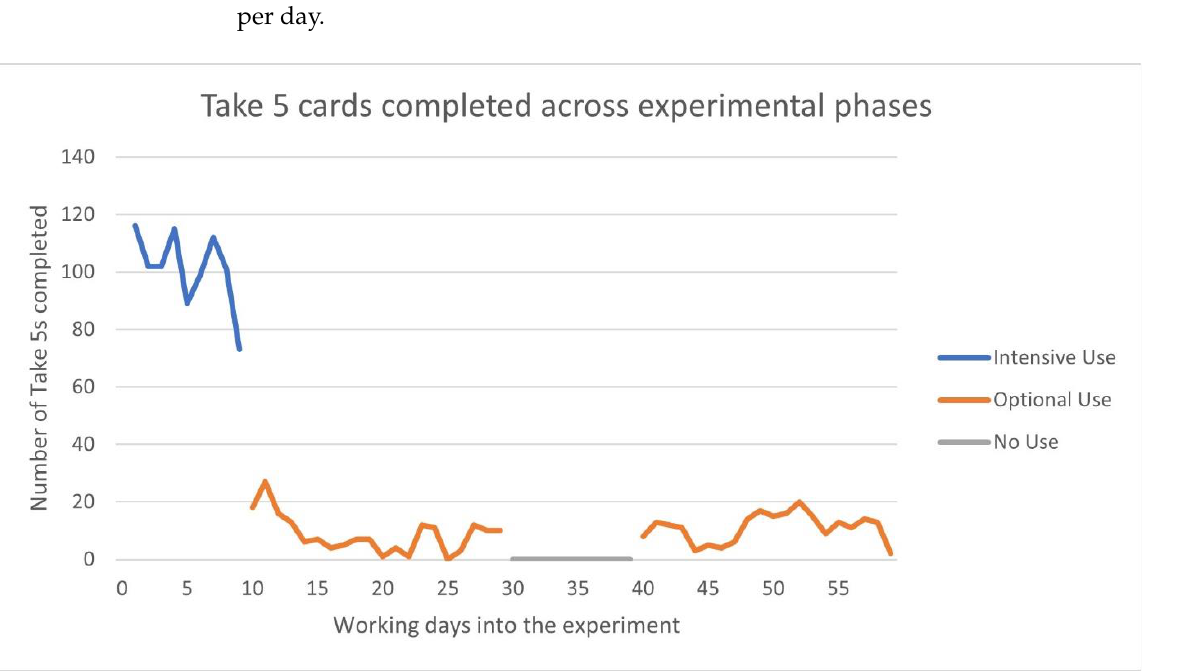
Figure 1. Take 5 usage over